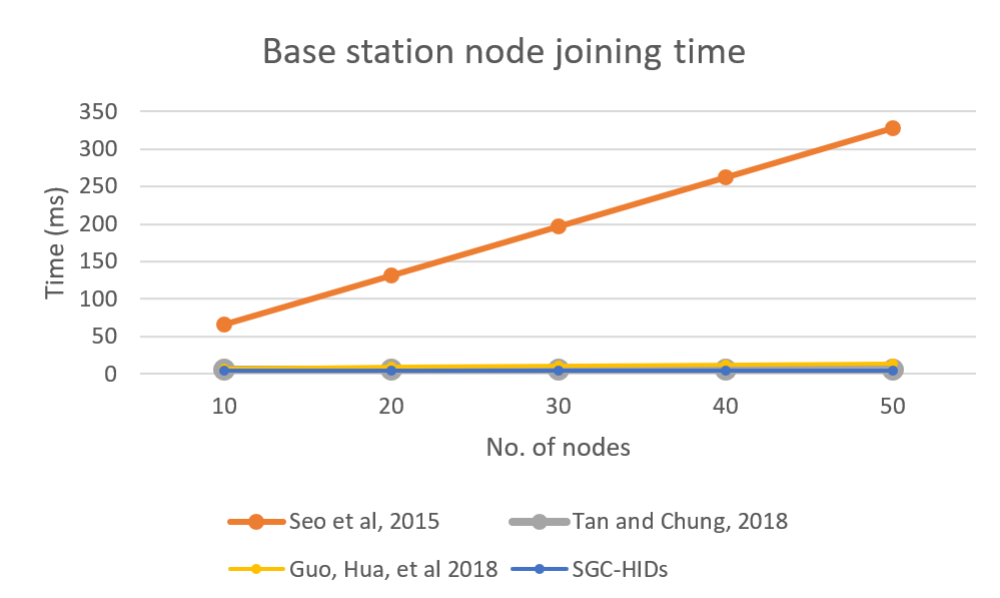
Figure 11. Base station computation time needed for node joining the group.